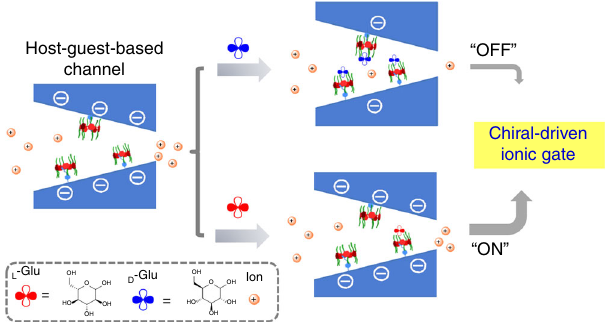
Fig. 5 The mechanism of glucose-enantiomer-driven ion gate using host – guest